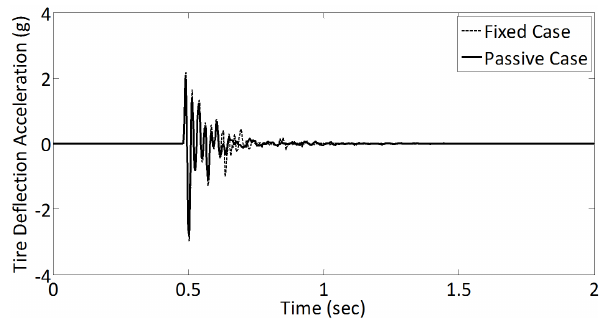
Figure 8. Drop Test: Tire Deflection Acceleration.